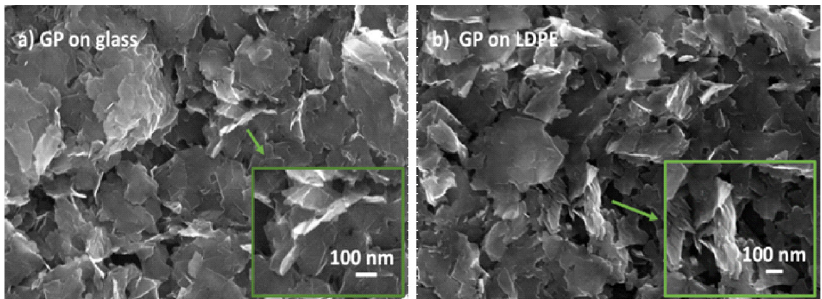
Figure 3. SEM micrograph of GP films deposited on glass ( a ) and LDPE ( b ). The insets show a magnification of platelets tilted with respect to the substrate planar surface.